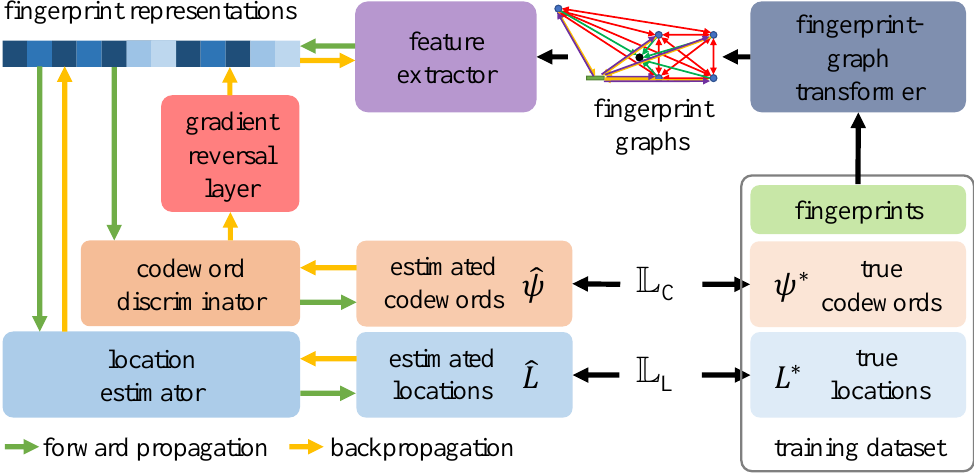
Figure 9. Our proposed localization system framework (for offline